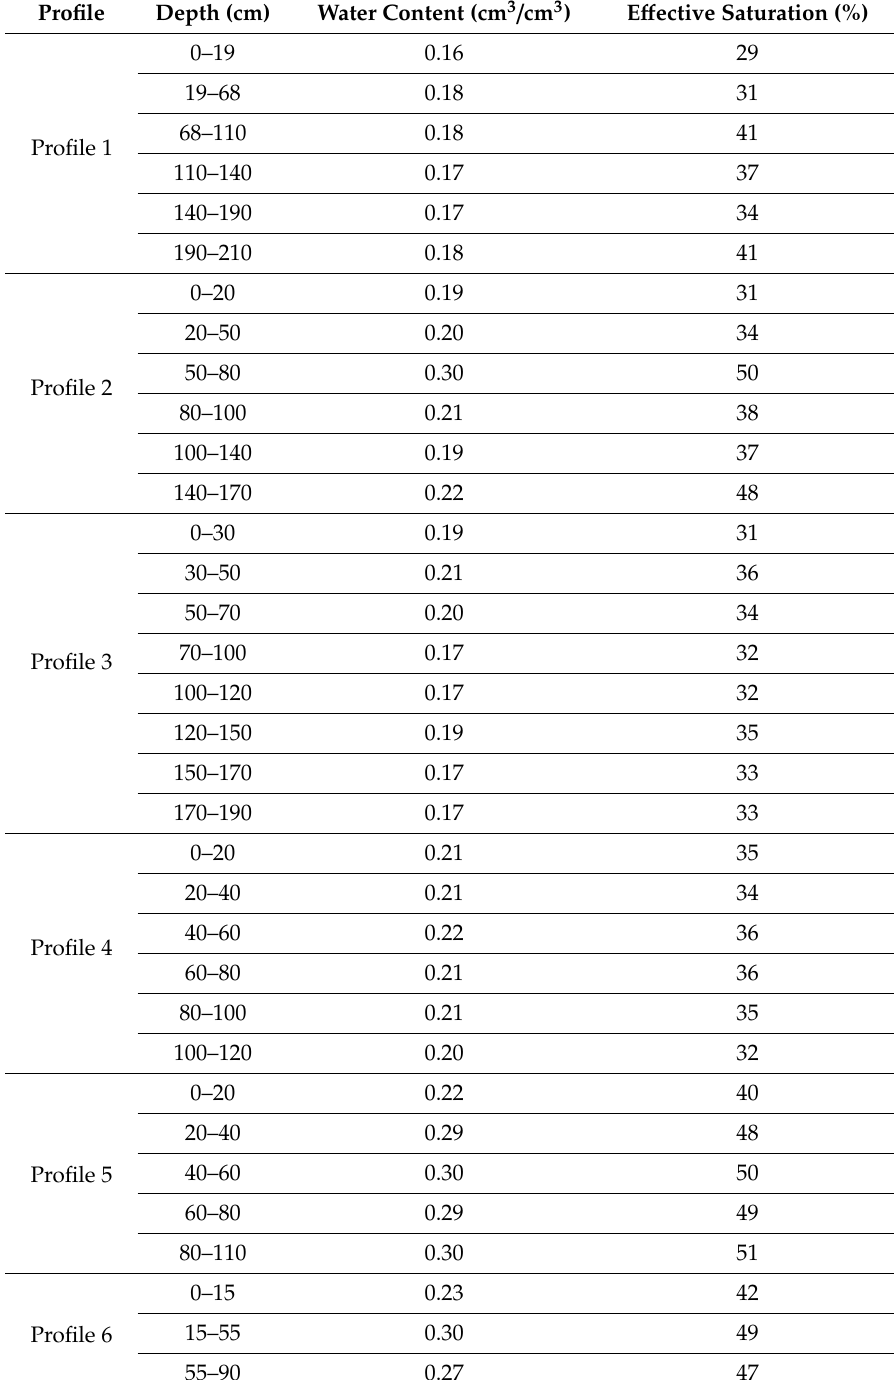
Table 5. Values of the water content and e ff ective saturation that generate impermeability in the investigated soil